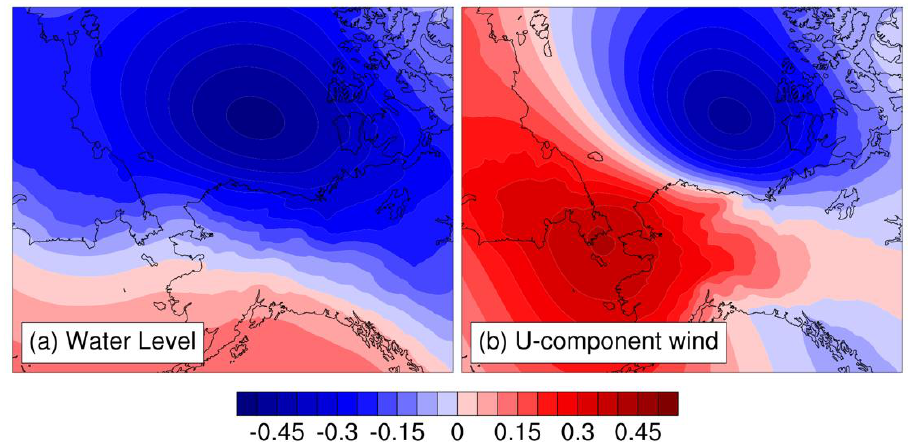
Figure 8. Correlation of daily mean ( a ) water level at Prudhoe Bay, and ( b ) east–west u-component of the wind at Deadhorse with the daily gridded sea level pressure for the available period of record. All correlations are significant at the 95% or greater level within the domains shown in ( a ) and ( b ). Trends in seasonal historical sea level pressure (SLP) and the long-term average clima-